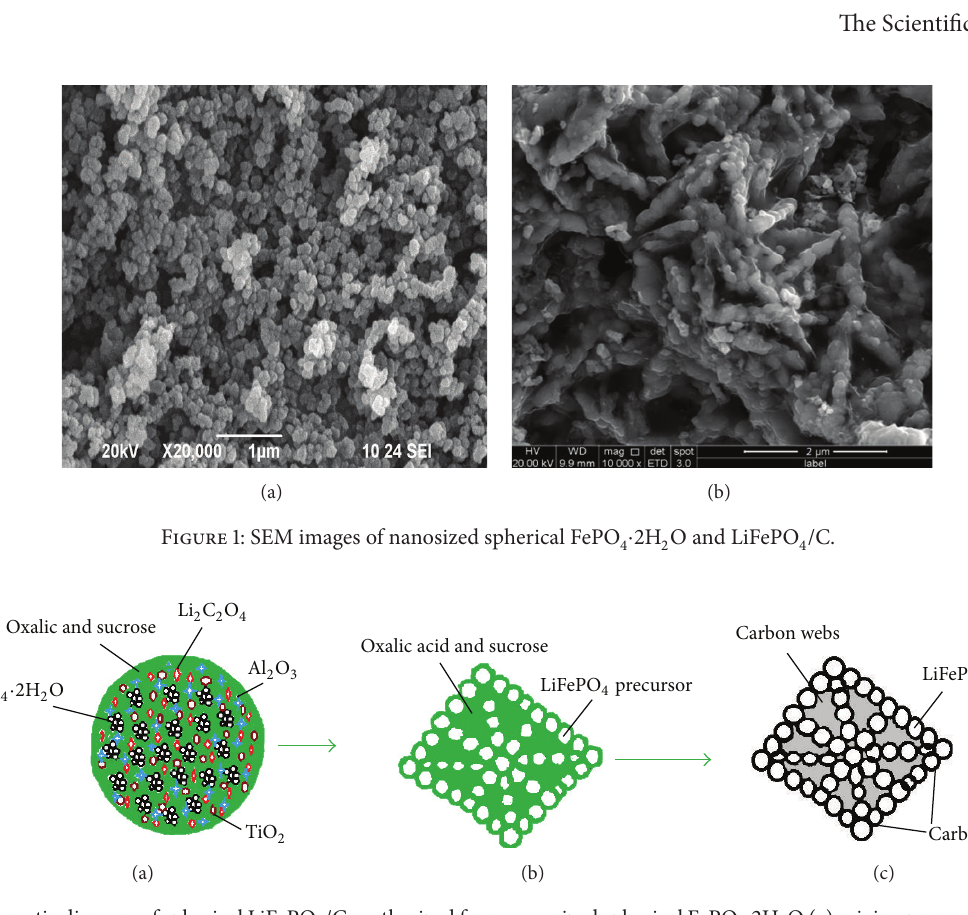
Figure 2: Schematic diagram of spherical LiFePO 4 /C synthesized from nanosized spherical FePO 4 ⋅ 2H 2 O (a) mixing process, (b) presintering stage and (c) sintered product.